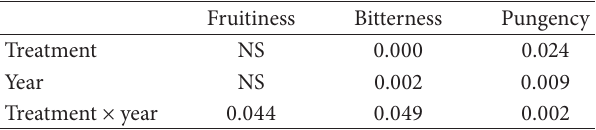
Table 7: MANOVA (prob. > 𝐹 ) of VOO sensory characteristics as a function of treatment and year ( 𝑛 = 3